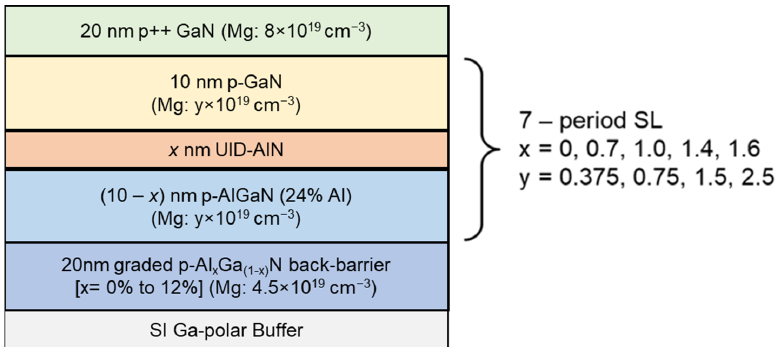
Figure 1. Structure of SL samples epitaxially grown using MOVPE for this work. The individual SL period had a thickness of 20 nm and was composed of (10 − x ) nm p-AlGaN/ x nm u.i.d. AlN/10 nm p-GaN, where, x , the AlN layer thickness was 0 nm ≤ x ≤ 1.6 nm. For each of the AlN thickness series samples, the p-type doping (Mg) was varied as 3.75 × 10 18 cm − 3 ≤ [Mg] ≤ 2.5 × 10 19 cm − 3 . A 20 nm p++ GaN contact layer was also grown in situ to facilitate high-quality